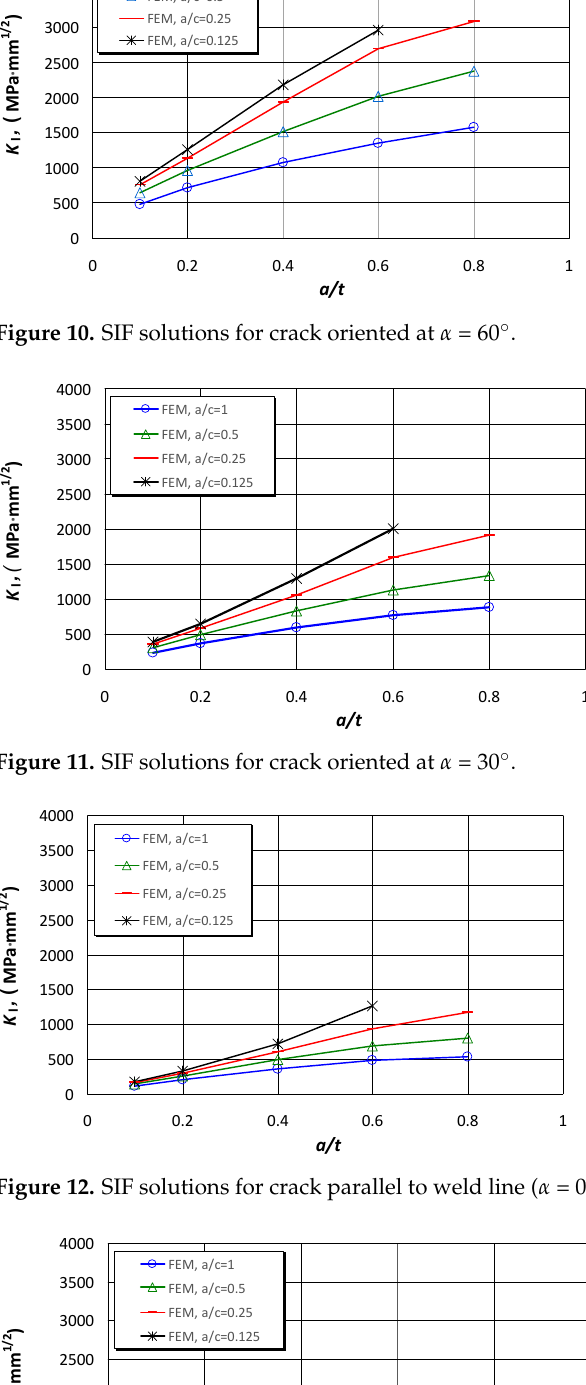
Figure 9. SIF solutions for crack perpendicular to weld line ( α = 90°).